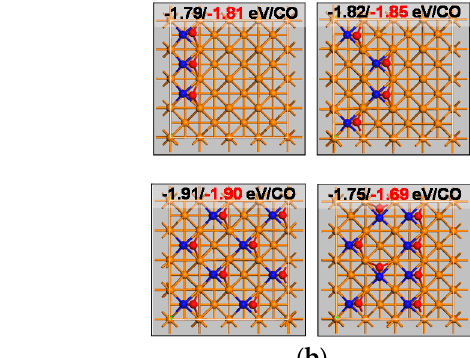
Table 1. DFT-optimized geometry of CO adsorbed on p(4x4)-Fe(100) ( Θ CO = 0.25 ML) in different geometric configurations (see Figure